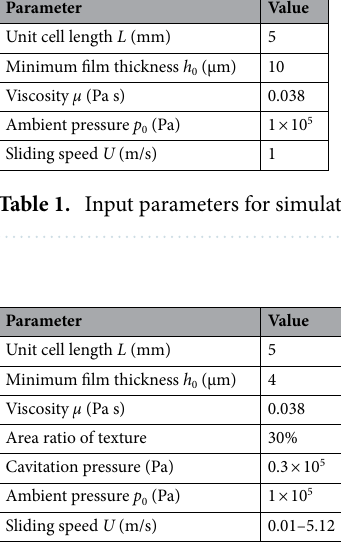
Table 2. Input parameters for simulation II.